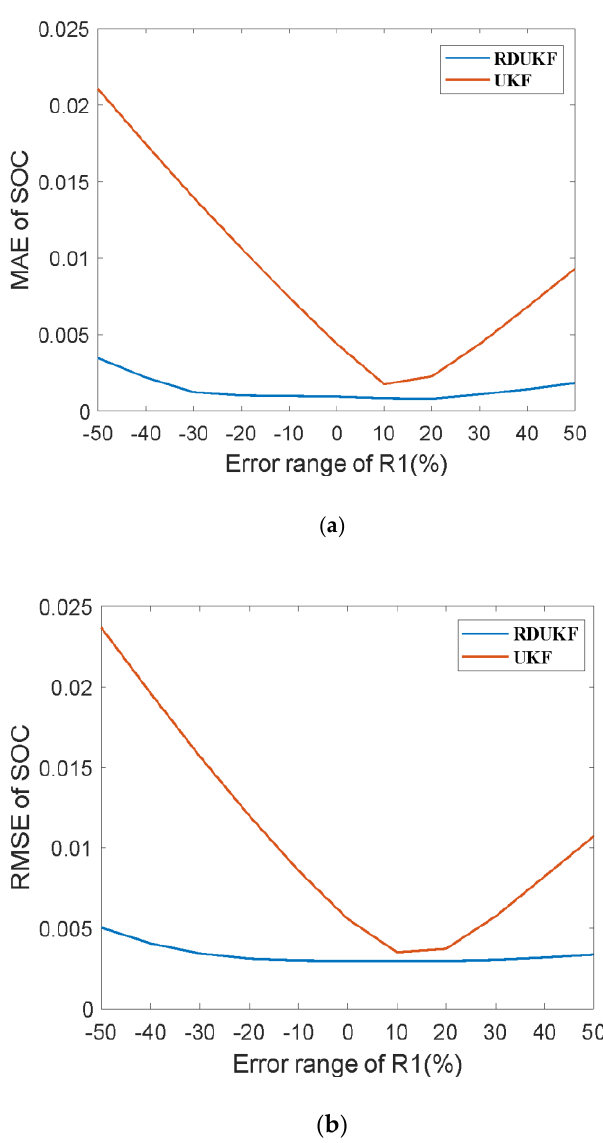
Figure 7. ( a ) RMSE according to deviations in R1; ( b ) MAE according to deviations in R1. Figure 8 shows the SOC estimation results and errors of the two methods, when R 0 undergoes a deviation of ±50% after 100 s. The UKF algorithm also diverges. The MAE and RMSE values obtained by the two methods under different model errors are shown in Figure 9. The RDUKF algorithm has a higher estimation accuracy, but under the same deviation ratio, it can be seen that the RDUKF is affected to a greater extent by the R 0 model parameters.